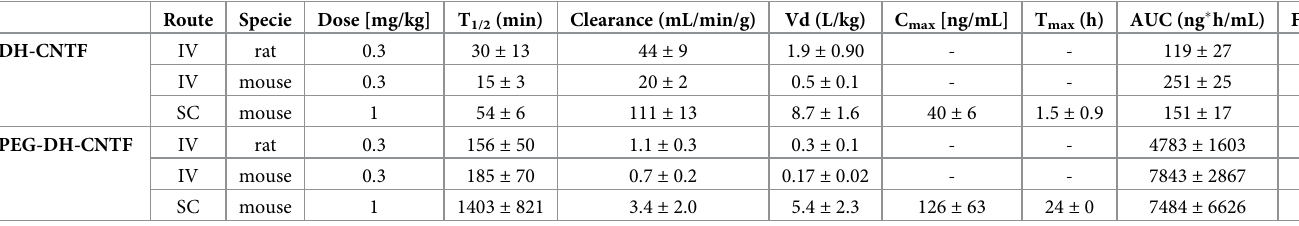
Table 2. Summary of pharmacokinetic